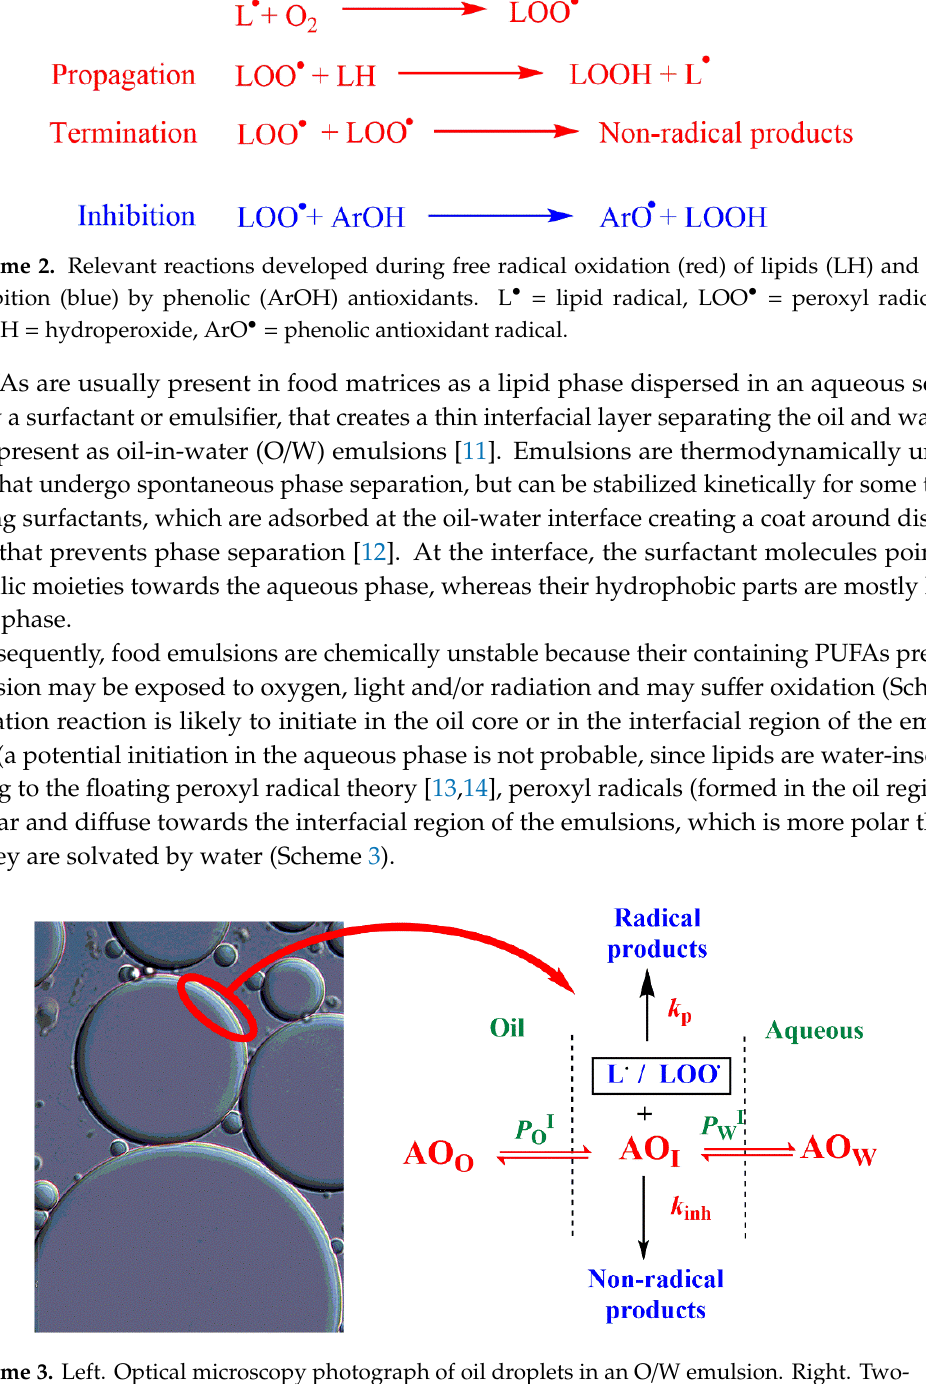
Scheme 3. Left. Optical microscopy photograph of oil droplets in an O/W emulsion. Right. Two- dimension representation of a small volume from an O/W emulsion containing the oil, interfacial and aqueous regions. The representation also shows the reactions of radicals, L  and LOO  , with a lipid molecule, LH (propagation rate constant, k p ), and with an antioxidant, AO, that partitions between the oil-interfacial ( P OI ) and aqueous-interfacial ( P WI ) regions of the O/W emulsion (inhibition rate constant, k inh ). Propagation and inhibition reactions are displayed in Scheme